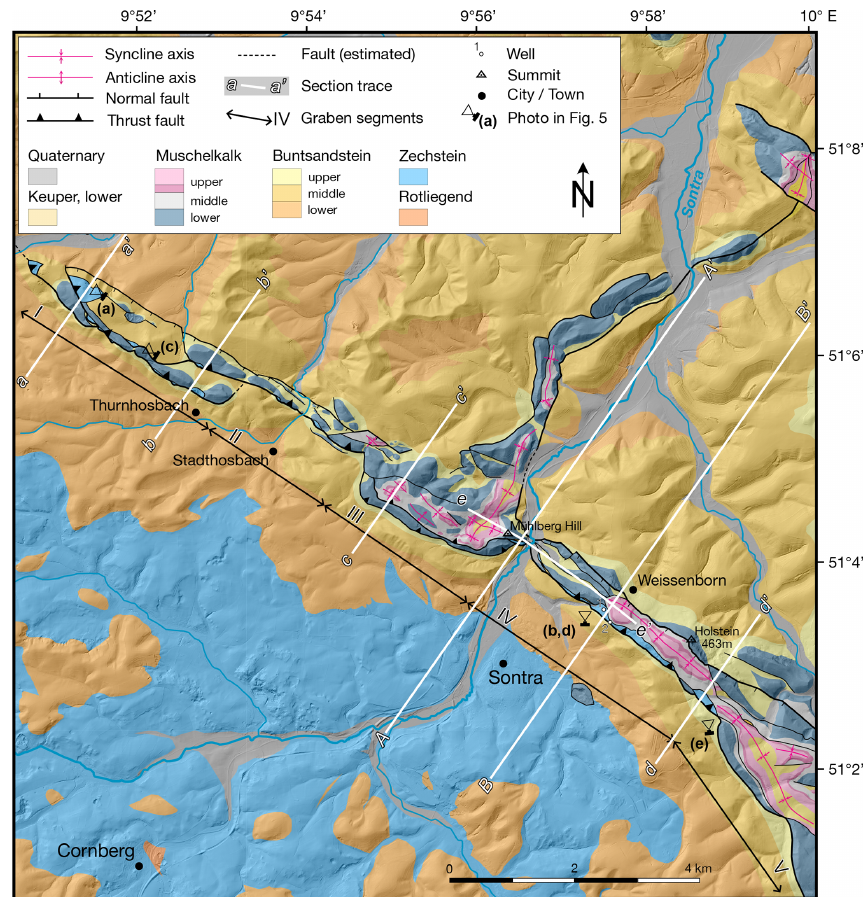
Figure 3. Geological map of the study area. Lines marked A–A (cid:48) and B–B (cid:48) indicate the position of the balanced cross sections in Fig. 6. Roman letters define sections of the graben between the dashed lines, which are referred to and further discussed in the text. Topography based on DEM data provided by the Geological Survey of Hessen (Hessisches Landesamt für Naturschutz, Umwelt und Geologie,